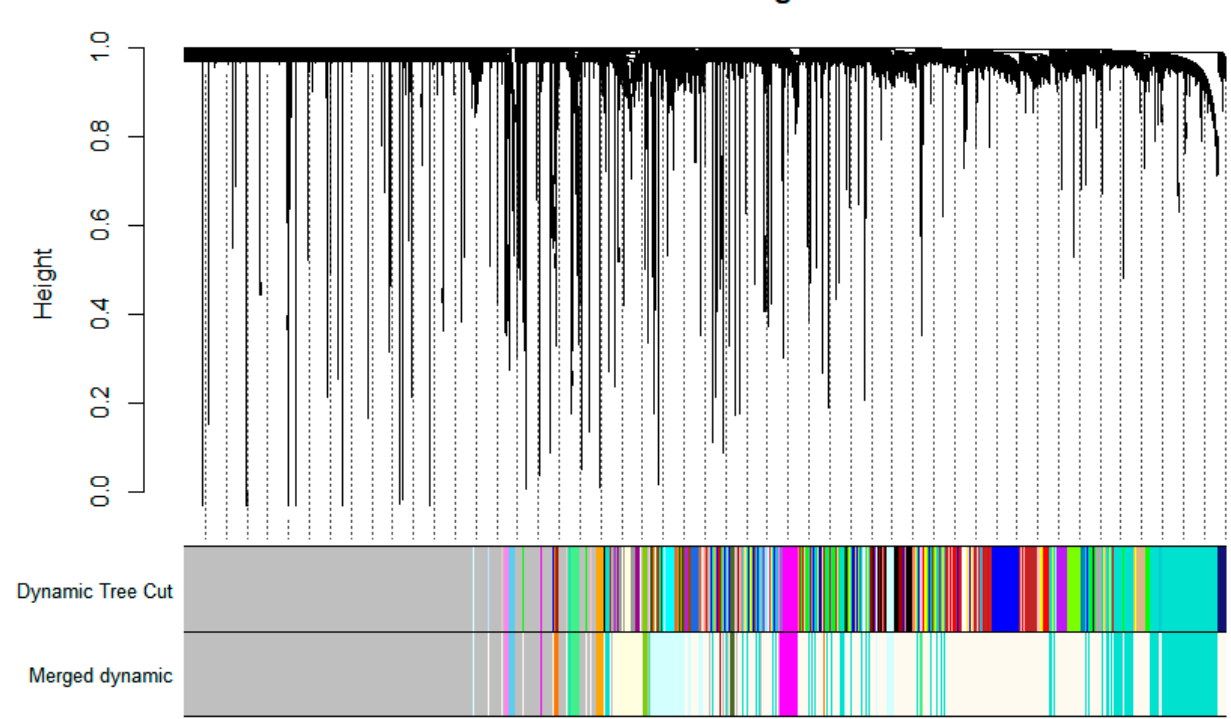
Figure 4. Cluster dendrogram of the fourteen identified modules from the network with each module being assigned a color. Genes in the grey module were not significantly clustered and were excluded in the analysis.